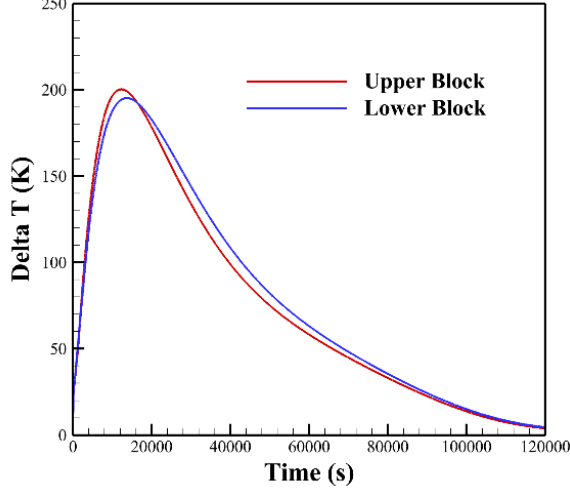
Figure 7. Transient temperature non-uniformities experienced by different blocks of Config-1-S0 during the heat treatment process.